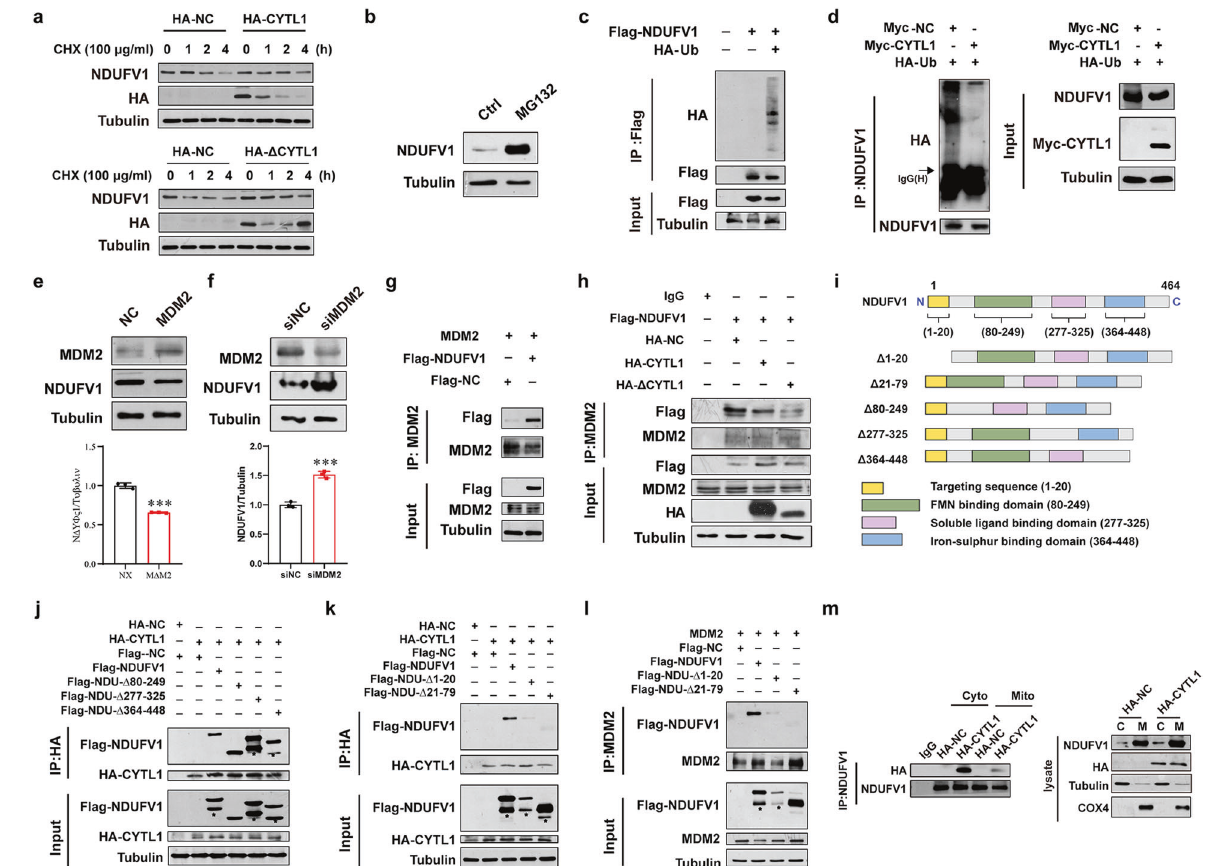
Fig. 5 Intracellular CYTL1 interrupts MDM2-mediated degradation of NDUFV1 by competitive binding. a The degradation of NDUFV1 over time in the presence of cycloheximide (CHX) was monitored by western blot in MDA-MB-231 cells transfected with HA-CYTL1 or HA- Δ CYTL1 expressing plasmids. b The NDUFV1 protein level in MDA-MB-231 cells before and after treatment of 20 μ M MG132 for 6 h. c Co-IP analysis of the interaction between Flag-NDUFV1 and HA-Ub in transfected HEK293T cells. d Co-IP analysis of the interaction between NDUFV1 and HA- Ub in HEK293T cells cotransfected with Myc-NC or Myc-CYTL1 after treatment of 20 μ M MG132 for 6 h. e , f NDUFV1 protein expression was determined by western blot in MDA-MB-231 cells transfected with e MDM2 expressing plasmid or f siRNA speci fi c for MDM2. Tubulin was used as a loading control. g Co-IP analysis of the interaction between MDM2 and Flag-NDUFV1 in transfected HEK293T cells. h Co-IP analysis of the interaction between MDM2 and Flag-NDUFV1 in transfected HEK293T cells cotransfected with HA-NC, HA-CYTL1, or HA- Δ CYTL1. i Schematic representation of NDUFV1 mutants that have truncated sequences. j Co-IP analysis of the interaction between HA-CYTL1 and Flag-NDUFV1 or its three mutants in transfected HEK293T cells. Stars indicate non-speci fi c bands. k Co-IP analysis of the interaction between HA-CYTL1 and Flag-NDUFV1 or its two mutants with deletion of N-terminal sequences. l Co-IP analysis of the interaction between MDM2 and Flag-NDUFV1 or its two mutants. m Cytoplasmic and mitochondrial protein were extracted from HEK293T cells transfected with HA-NC or HA- CYTL1. Co-IP analysis was performed for the interaction between endogenous NDUFV1 and HA-CYTL1. The data are shown as the mean ± SD of three independent experiments. *** P < been linked to the inhibition of the cell growth and metastasis of breast cancer both in vitro and in vivo. These fi ndings highlight CYTL1 as a novel tumor suppressor. Cancer is identi fi ed by various hallmarks that indicate its malignant progression, including robust facilitation of glycolytic switching. 5 For this metabolic switching, oncogenes are typically activated and tumor suppressors are inactivated in tumors. In the case of breast cancer, a negative correlation between malignant progression and the intracellular level of CYTL1 was observed. The trend of profound reduction in CYTL1 level in advanced tumors suggests the possibility that CYTL1 can be recognized as a suppressor that hinders tumor progression. In contrast to suppressors known to be prone to mutation, i.e., p53 and PTEN, to our knowledge, CYTL1 harbors rare loss-of-function variants. 17,31 These features of CYTL1 as a novel tumor suppressor may be very important not only for our understanding of tumor suppressors but also for the development of new antitumor approaches.